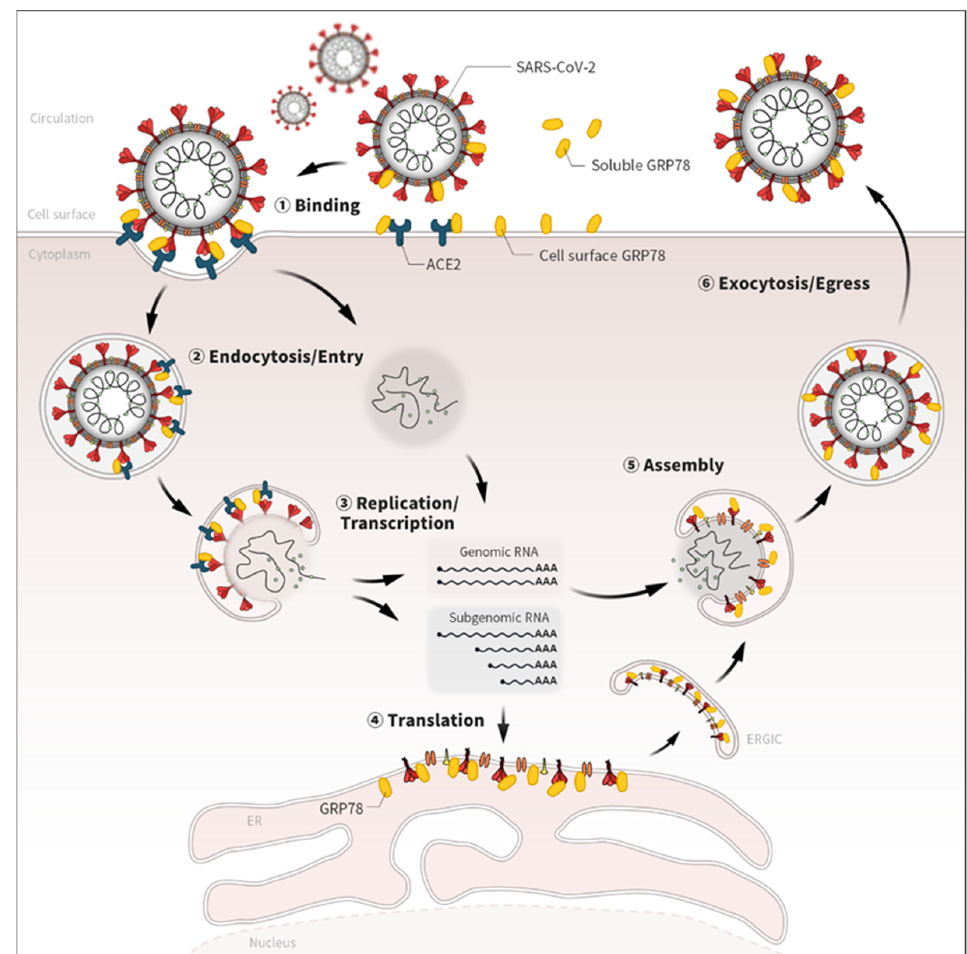
Figure 2. Potential roles of GRP78 in the life cycle of SARS-CoV-2. Emerging evidence has shown that GRP78 directly binds with several viral proteins of SARS-CoV-2 [12,15,16,18]. Given the localizations and biological roles, GRP78 could also contribute to various life-cycle stages of SARS-CoV-2, not only the binding but also the endocytosis/entry, replication, translation, assembly, and exocytosis/egress processes.